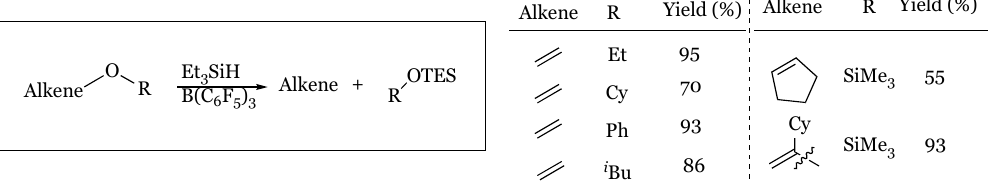
Figure 2. Representative reductions of enol ethers with triethylsilane.